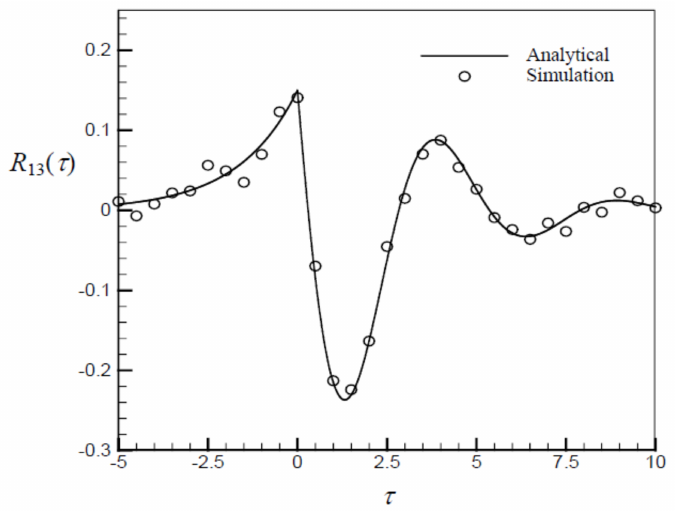
Figure 6. Cross − correlation function R 13 ( τ ) of X 1 ( t ) and X 3 ( t ) for Equation (9) using the method of series expansion with random